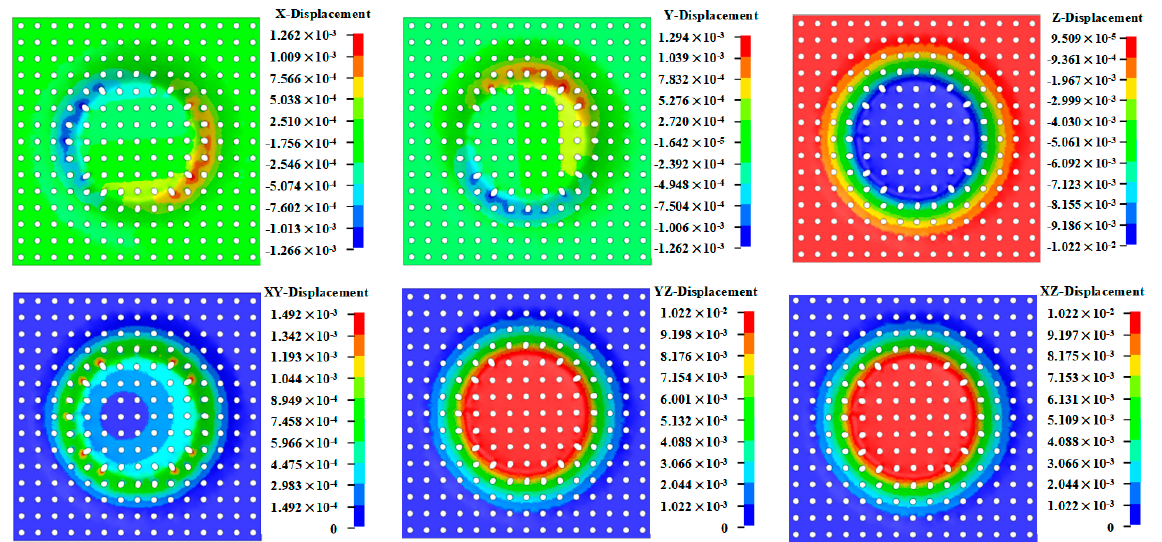
Figure 14. Cloud map of perforated titanium sheet displacement field.